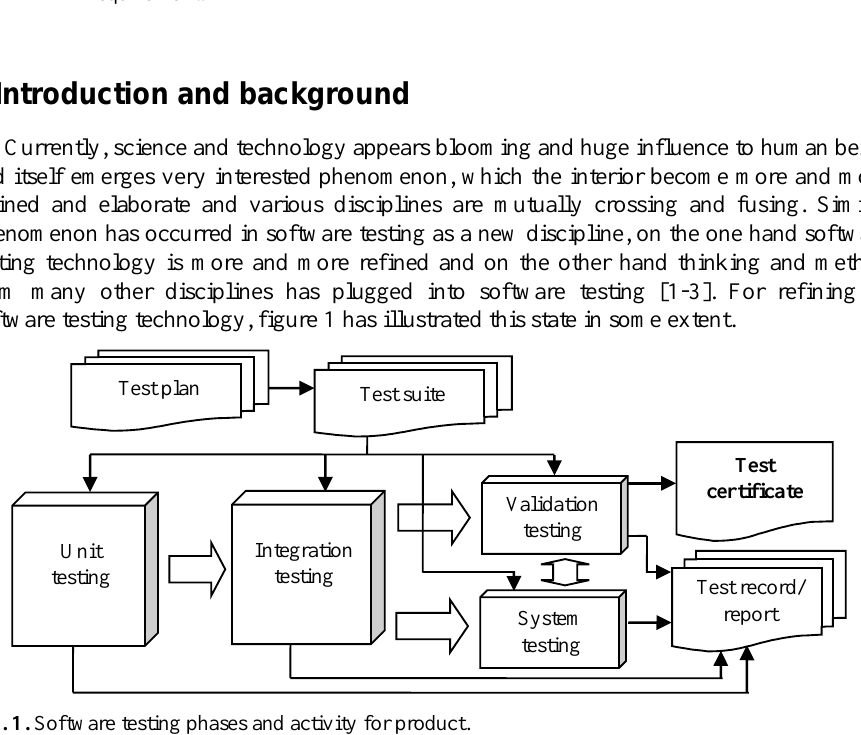
Fig. 1. Software testing phases and activity for